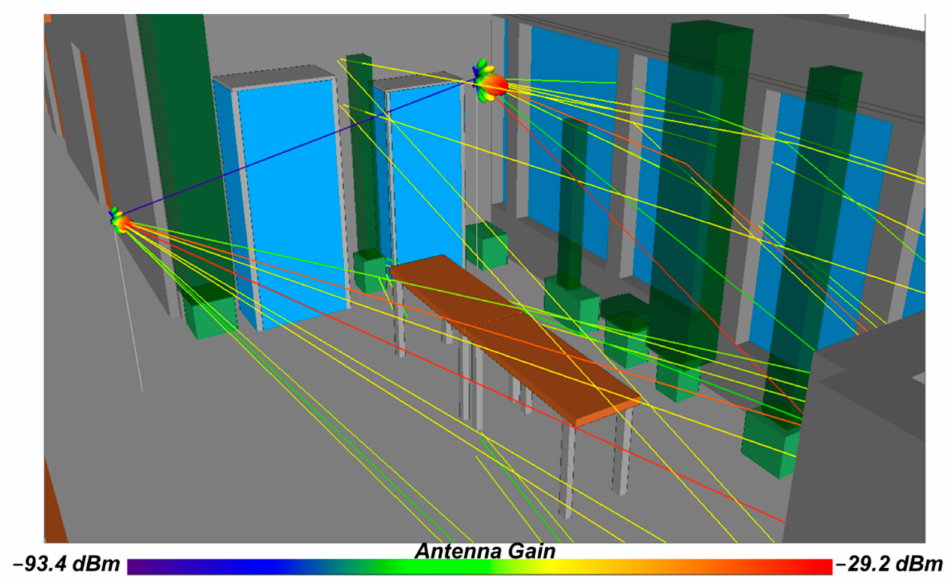
Figure 8. Reflection from the concrete wall (strongest path for all Rx1 points).